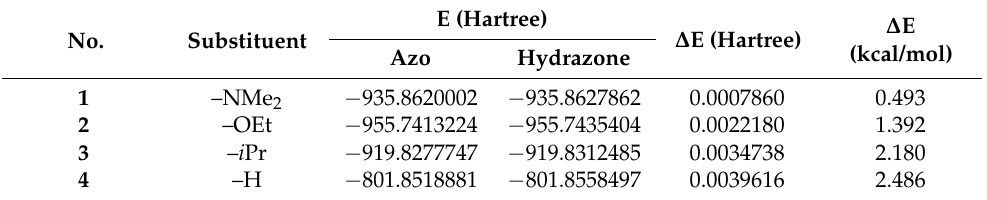
Table 3. Energies of azo and hydrazone forms of 1-phenylazonaphthalen-2-ols ( 1–4 ) estimated in DMSO at the B3LYP/6-311++G(d,p) level of theory. ∆ E represents the difference between azo and hydrazone form ( ∆ E = E a − E h